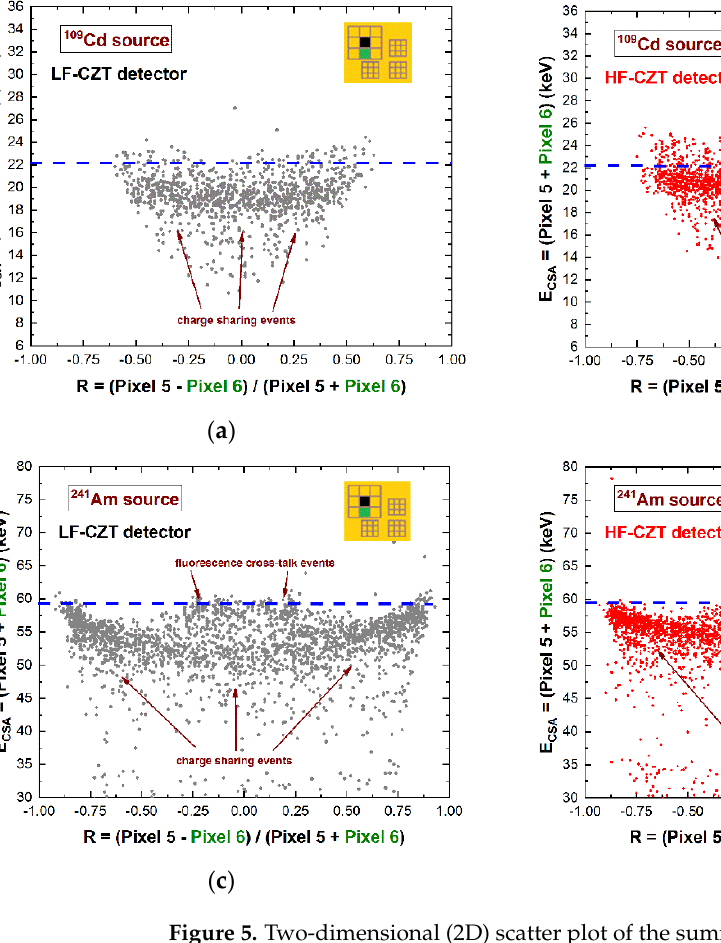
Figure 5. Two-dimensional (2D) scatter plot of the summed energy E CSA of the coincidence events ( m = 2) between two adjacent pixels (central pixel no. 5 and pixel no. 6), after CSA, versus the charge-sharing ratio R . The plots highlight the dependence of the energy deficit on the position within the inter-pixel gap and the higher charge losses of ( a ), ( c ) the LF-CZT than ( b ), ( d ) the HF-CZT detector.